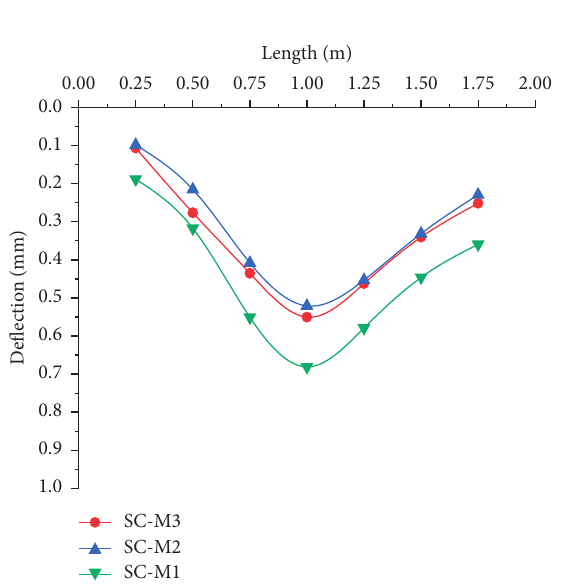
Figure 14: Deflection curves of flexural